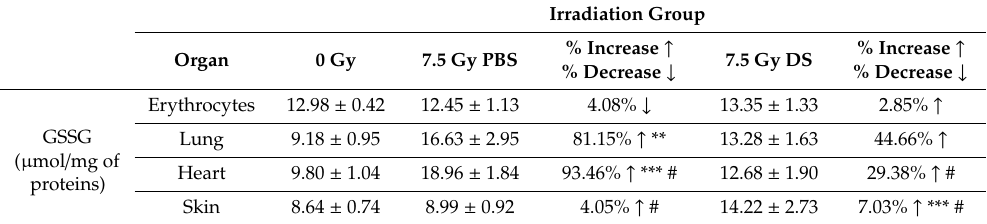
Table 4. GSSG in erythrocytes, lung, heart and skin of mice irradiated by PBS or DS proton beams in the plateau phase of the Bragg